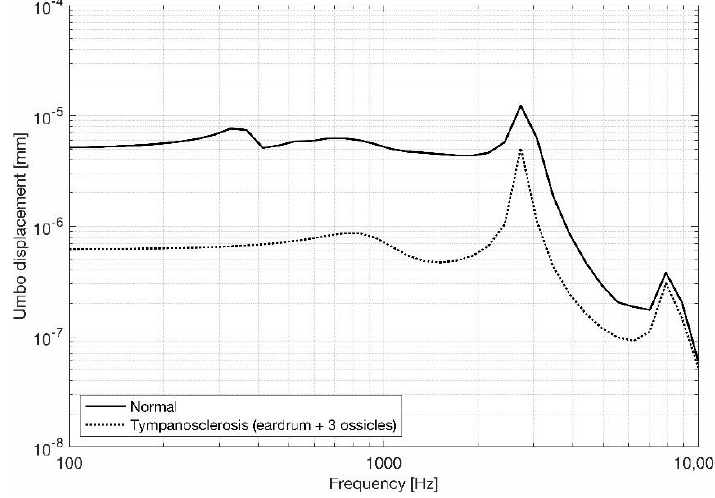
Figure 6. Umbo displacements’ magnitude, comparing the model that was representative of a normal ear and tympanosclerosis affecting the eardrum and the three ossicles.